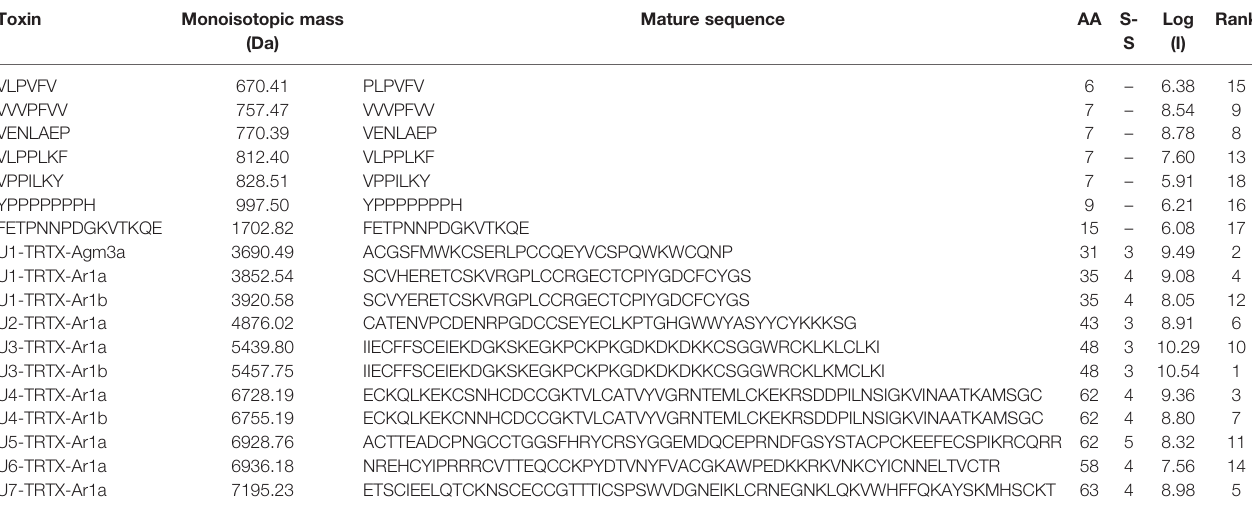
TABLE 1 | Mature toxins identi fi ed and validated in Acanthoscurria rondoniae peptidomic venom fraction.